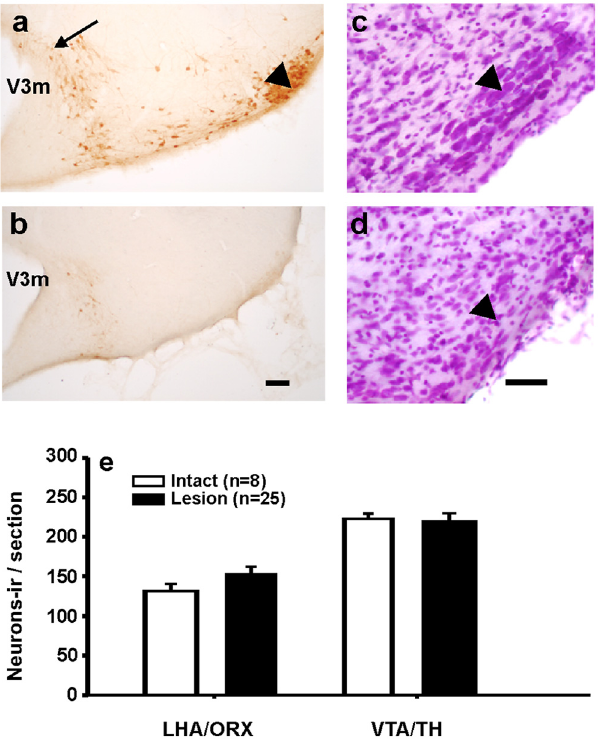
Fig 3. Quantification of the OrxB-SAP ribotoxin lesion of the TMN and adjacent structures. Photomicrographs of sections stained for ADA-ir ( a, b ) and Nissl substance ( c, d ). (a) and (c) show an intact TMN, ( b ) and ( d ) represent a large TMN lesion (77%) that involved the ventral (arrowhead) and the dorsal TMN (arrow). (e) , the quantification of Orx-ir neurons in the LHA or TH-ir neurons in the ventral tegmental area (VTA), demonstrated that these adjacent regions that express Orx receptors were spared by the Orx- SAP injections. No statistical differences were detected (Mann Whitney test, p = 0.216 and 0.811 respectively). Scale bars = 200 μ m. V3m mammillary recess of the third ventricule.